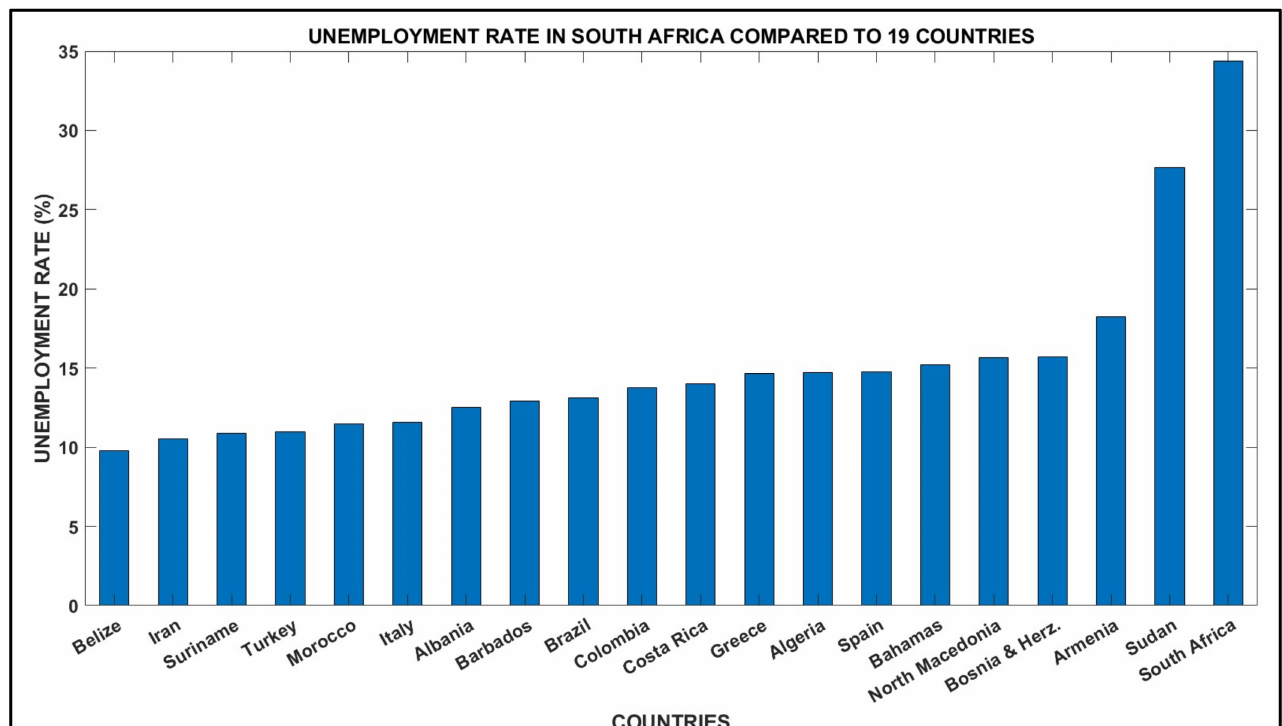
Figure 7. Unemployment rate in South Africa in comparison to other countries (adapted from